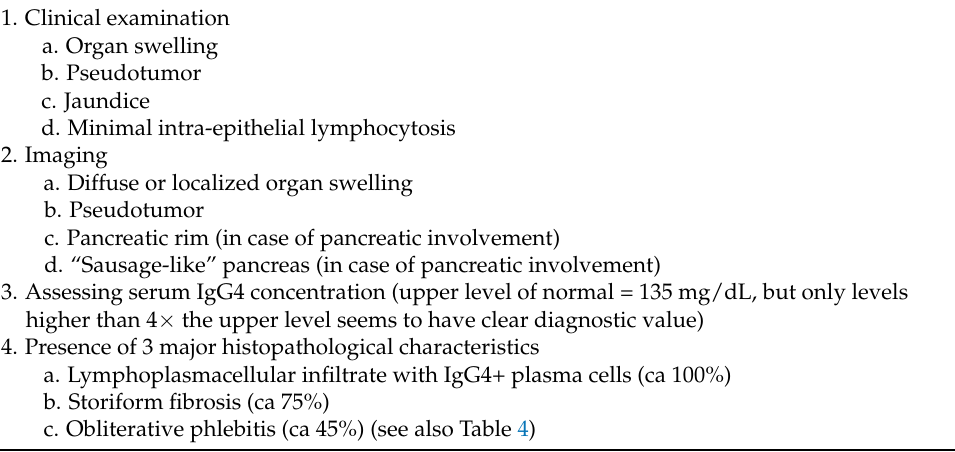
Table 3. Diagnostic criteria for IgG4-RD target organs (created in accordance with Backhus and Löhr et al.